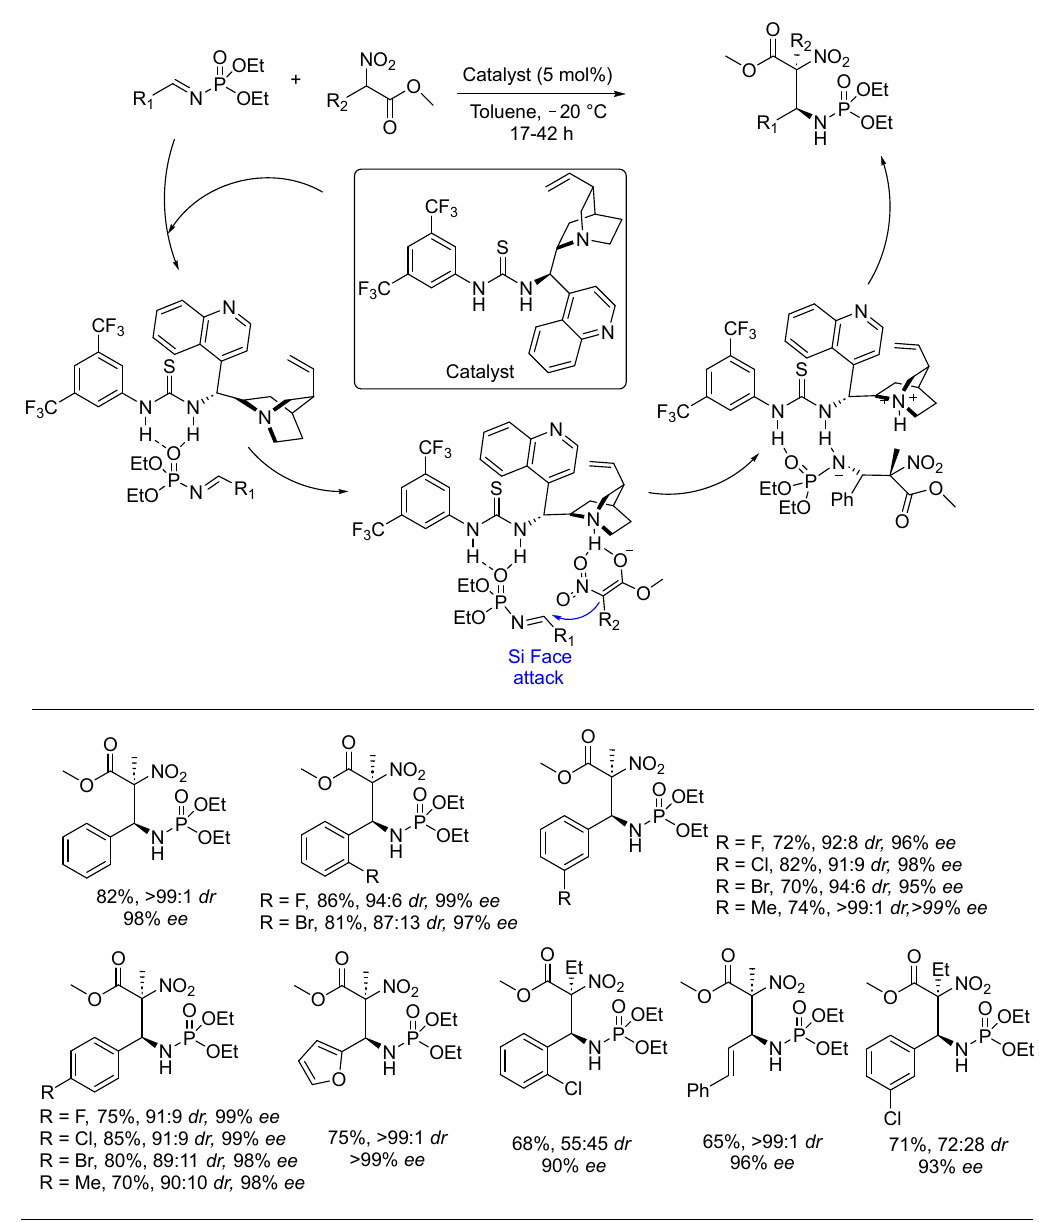
Scheme 19. The organocatalytic reaction of N -phosphoryl imine with α -substituted